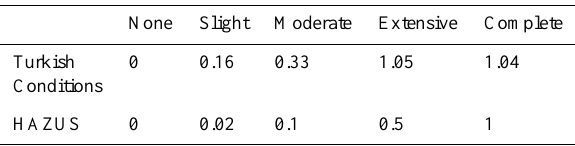
Turkish vs. HAZUS mean damage ratios, Bal et al. (2008a). None Slight Moderate Extensive